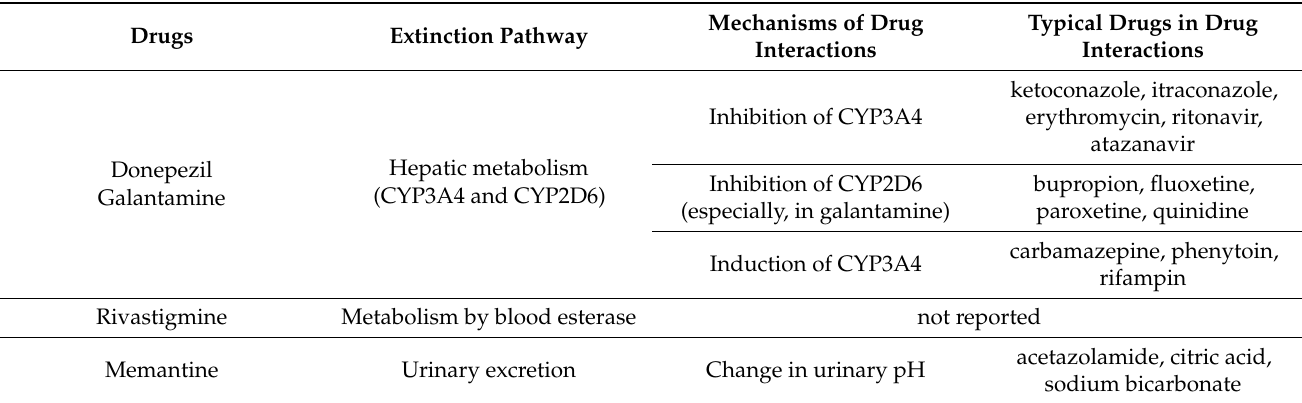
Table 1. Pharmacokinetic Drug Interactions in Alzheimer’s Disease.